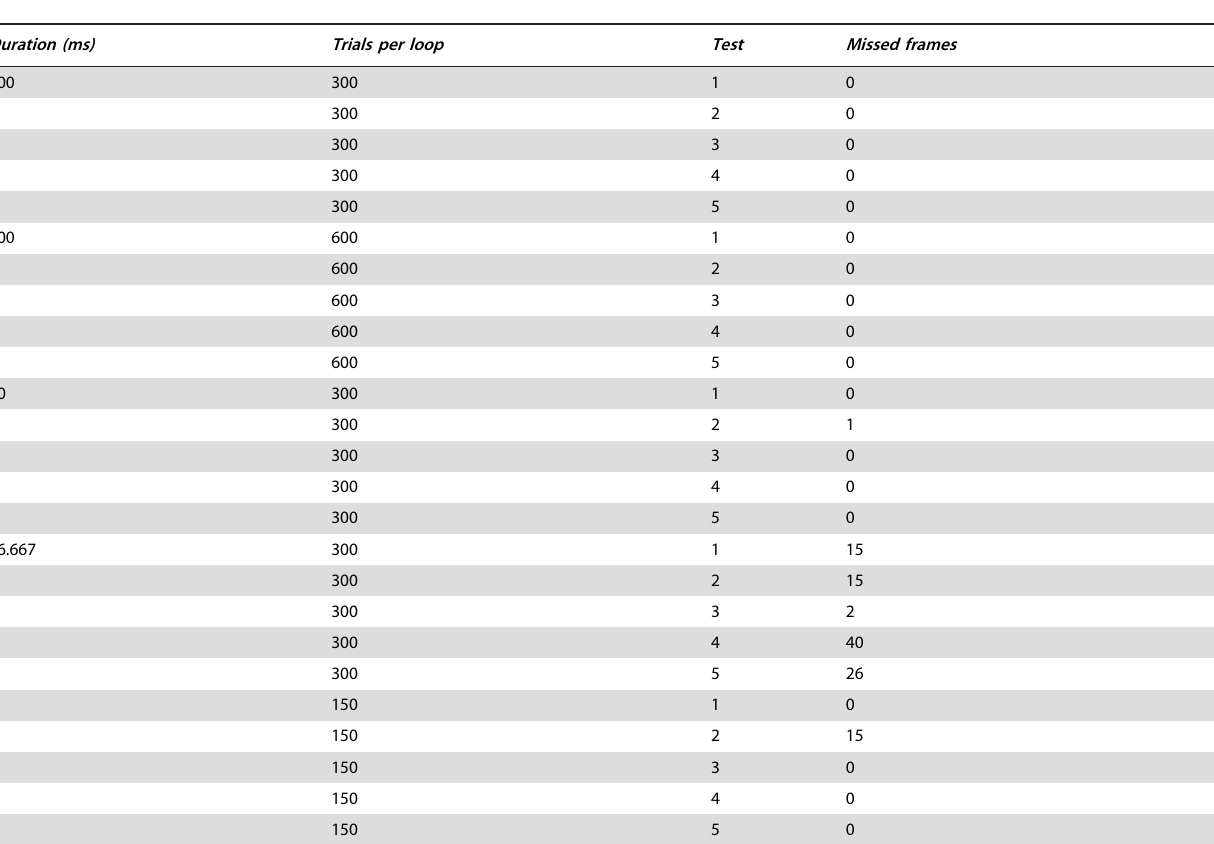
Table 3. PsychoPy 1.80 timing tests on MacBook Pro Late 2013 under Ubuntu Linux 13.10 ‘‘Saucy Salamander’’.